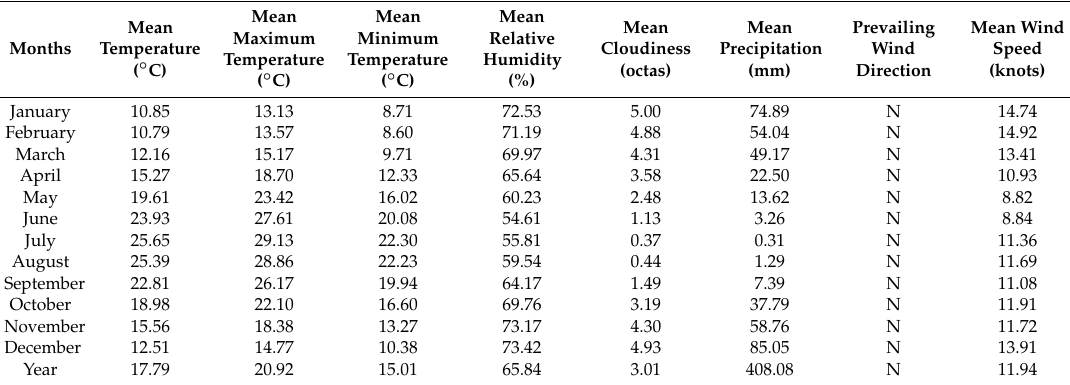
Table 1. Mean climatic characteristics for Milos island